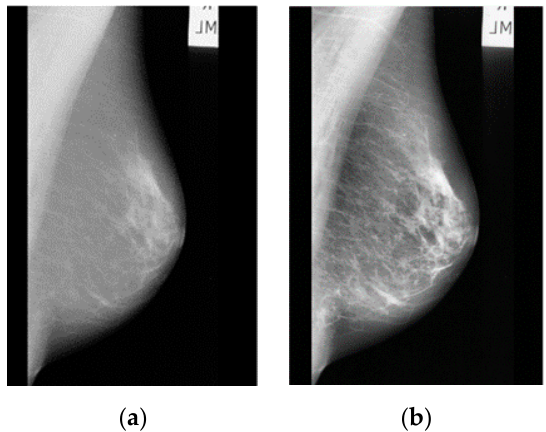
Figure 2. ( a ) Original abnormal mass case extracted from the Mammographic Image Analysis Society (MIAS) dataset [13] and ( b ) Enhanced image using contrast-limited adaptive histogram equalization method (CLAHE).